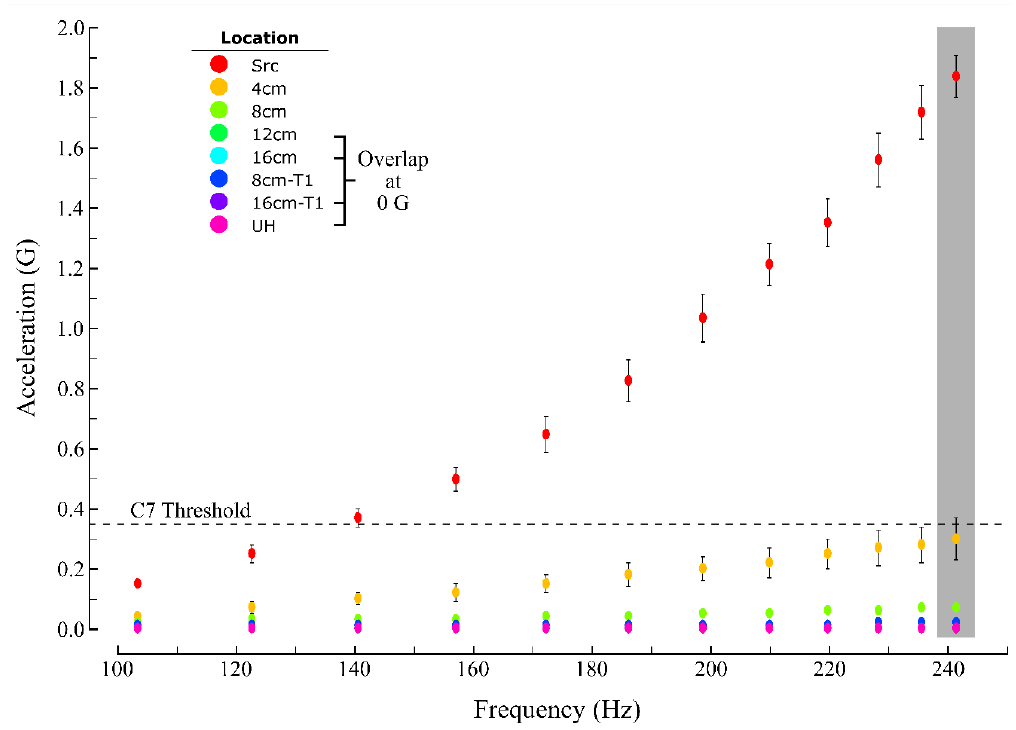
Figure 2. Mean acceleration (across participants) at different distances from a source vibration at various frequencies. The black dashed horizontal line shows the amplitude value of the vibrotactile intensity discrimination threshold for dermatome C7. The gray vertical bar marks the highest intensity vibration (241 Hz) acceleration values. Error bars show SEM.